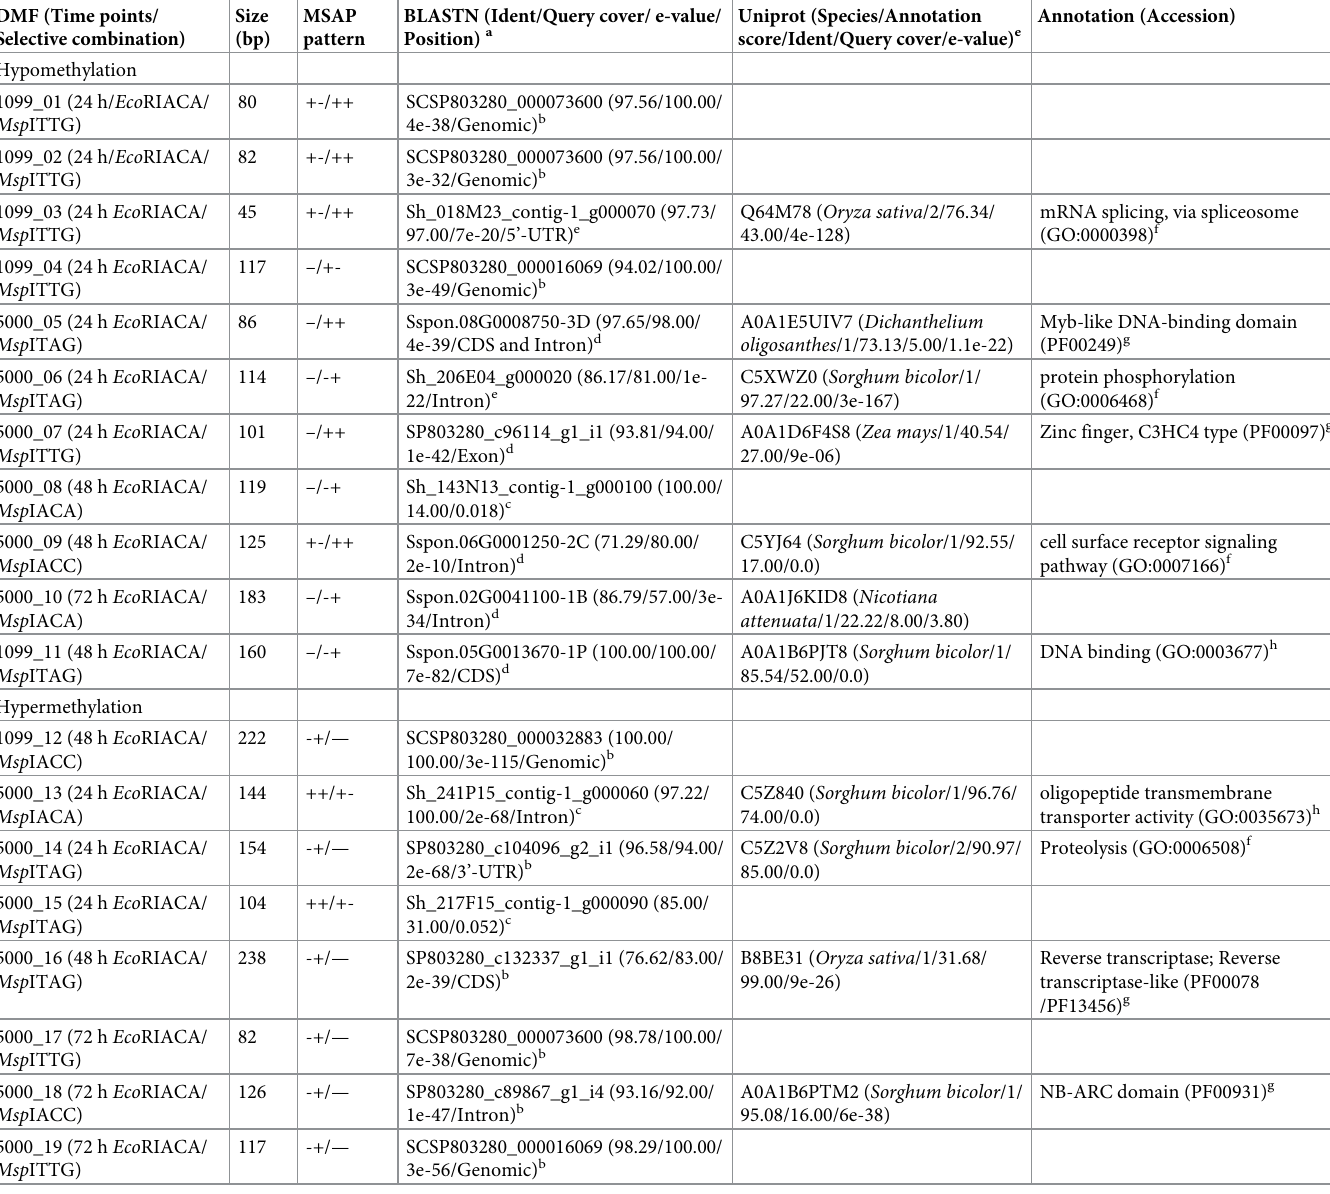
Table 3. BLASTN analysis of 19 differentially methylated fragments (DMFs) and BLASTX analysis of the sugarcane transcripts. (+) and ( − ) represent presence and absence of bands,